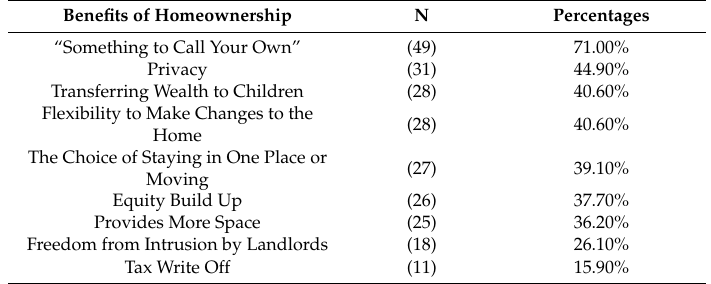
Table 12. Perceived Benefits of Homeownership of Houston Habitat Homeowners